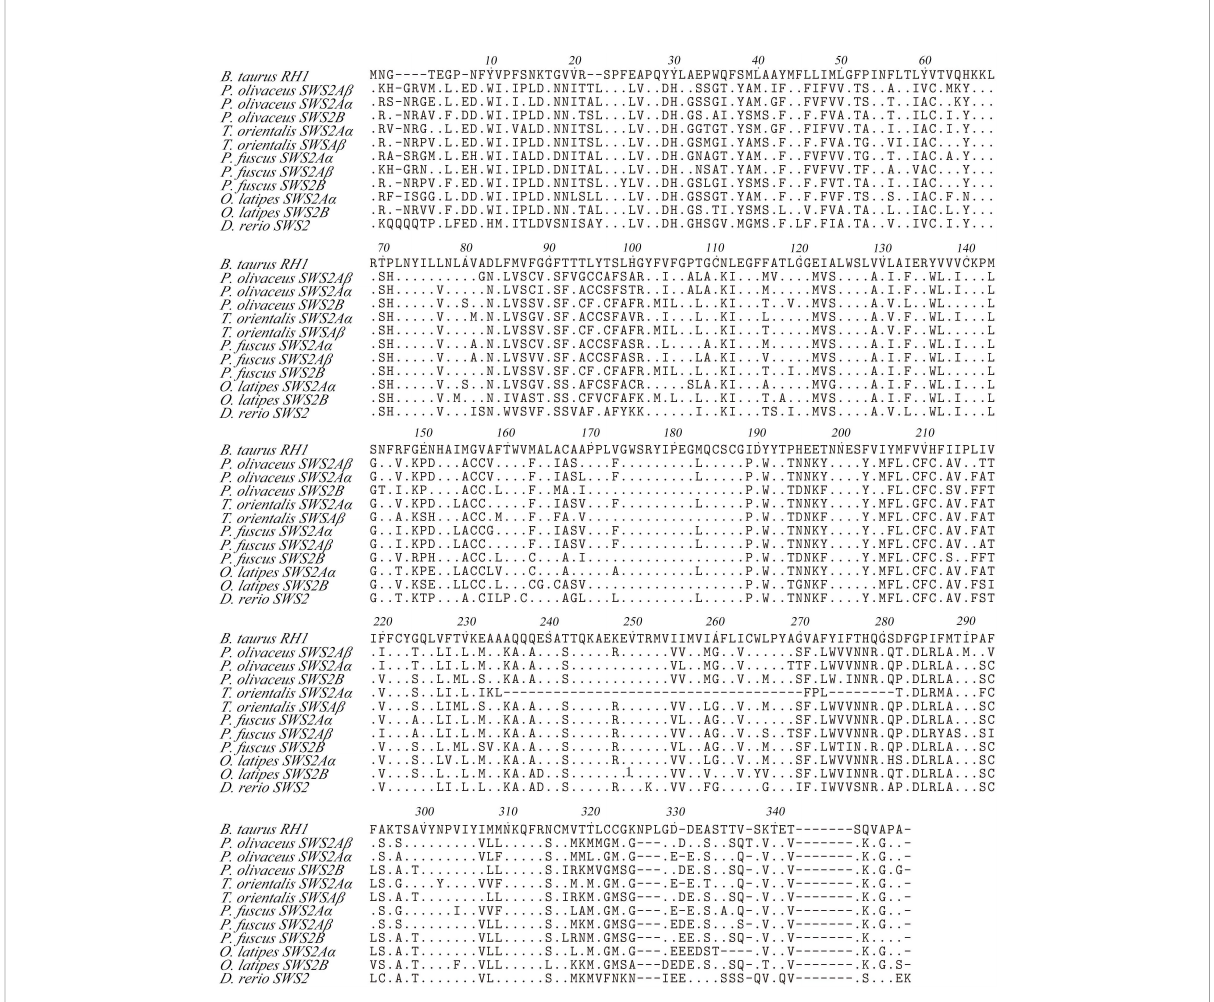
FIGURE 3 Amino acids alignment of SWS2. The dots represented the same amino acid sites compared with B . taurus RH1 sequence among different species. The horizontal lines represented the missing of amino acid sites compared with each